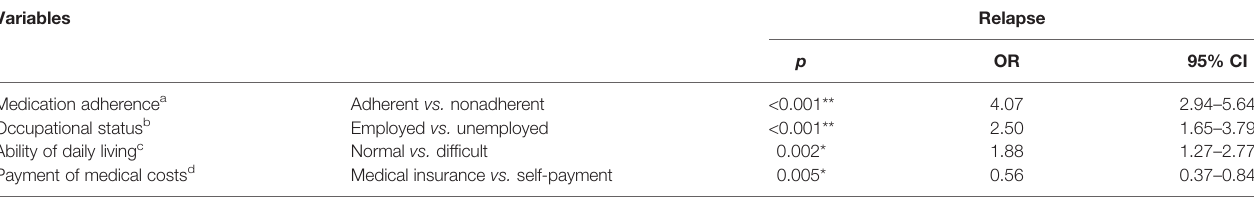
TABLE 3 | Logistic regression analysis of signi fi cant risk factors of